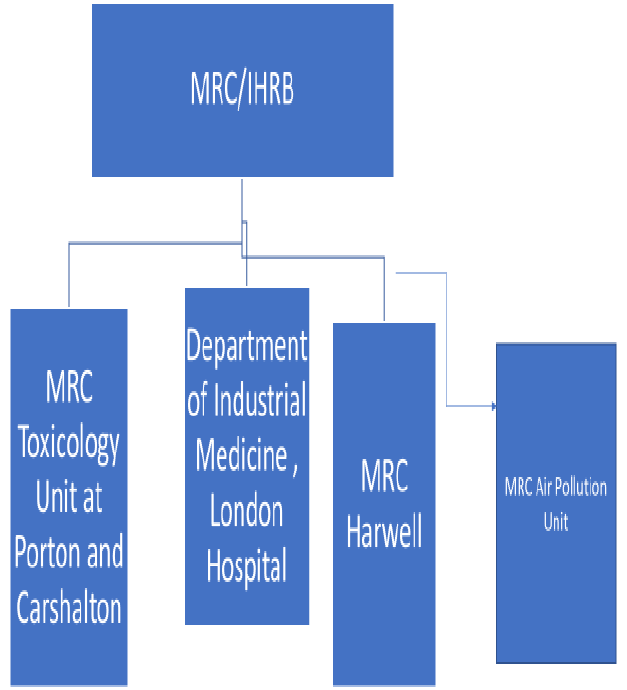
Figure 2. MRC links with atomic weapons and biological warfare bodies. UK medical research council/industrial health research board links with atomic weapons and biological warfare bodies.